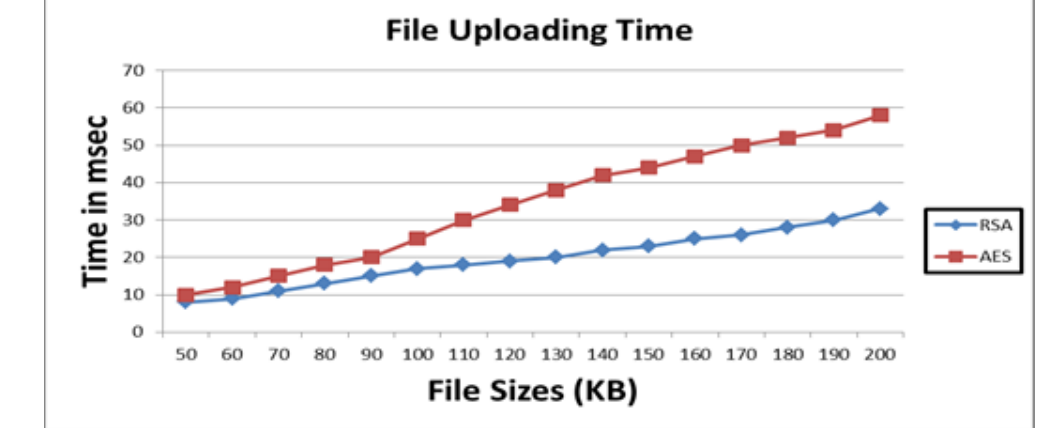
Figure 12 . File Uploading Time